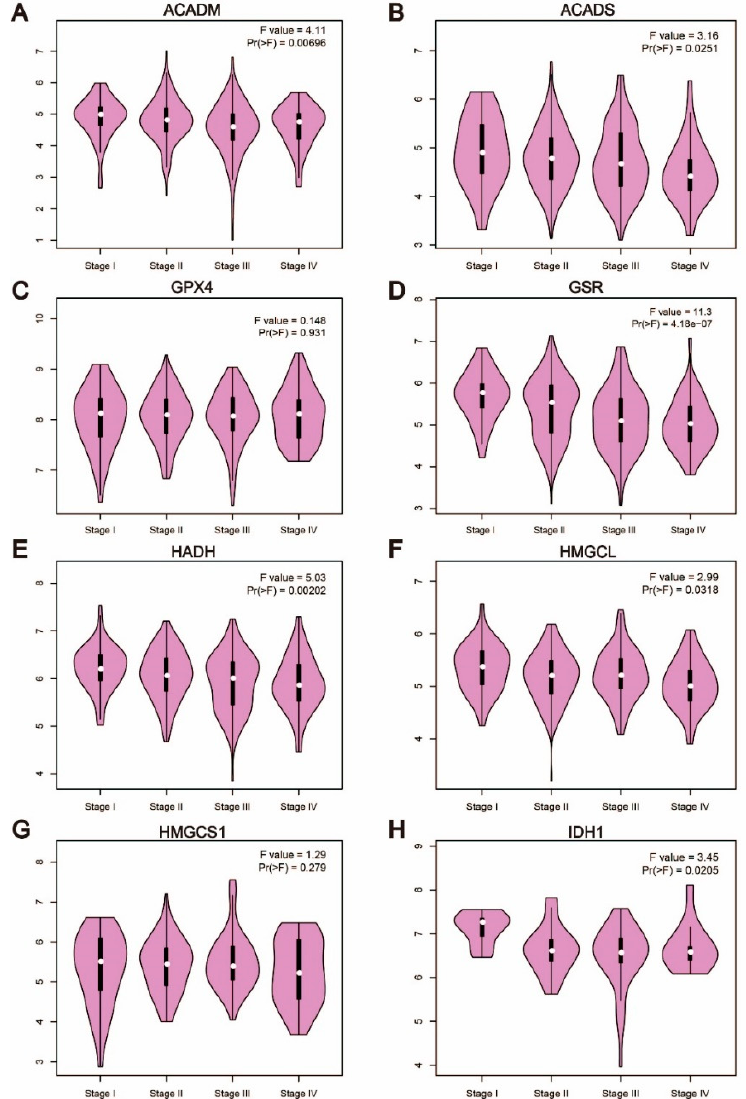
Figure 3. Low expression of key enzymes is associated with adverse clinicopathological features of CRC. ( A – H ). The relationship between the expression of these enzymes and the clinicopathological features of patients with colorectal cancer by GEPIA2. Apart from GPX4 and HMGCS1, the expression levels of the other six genes decreased with the deterioration of clinicopathological conditions in patients with colorectal